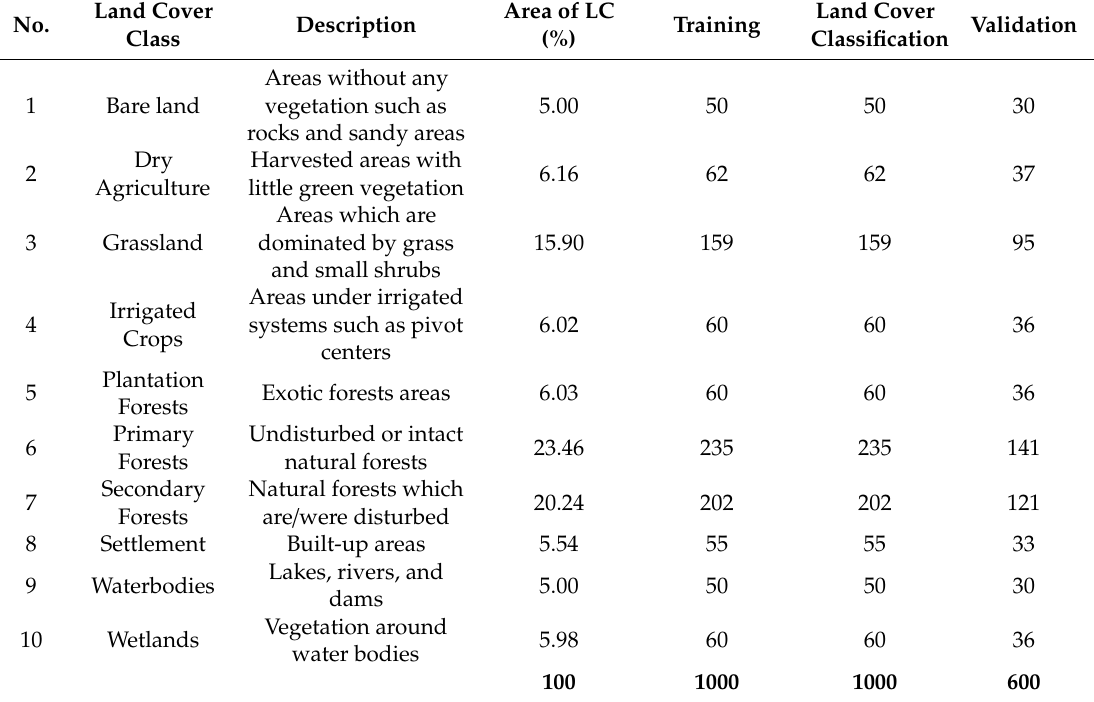
Table 1. Description of the 10 land cover classes used in this